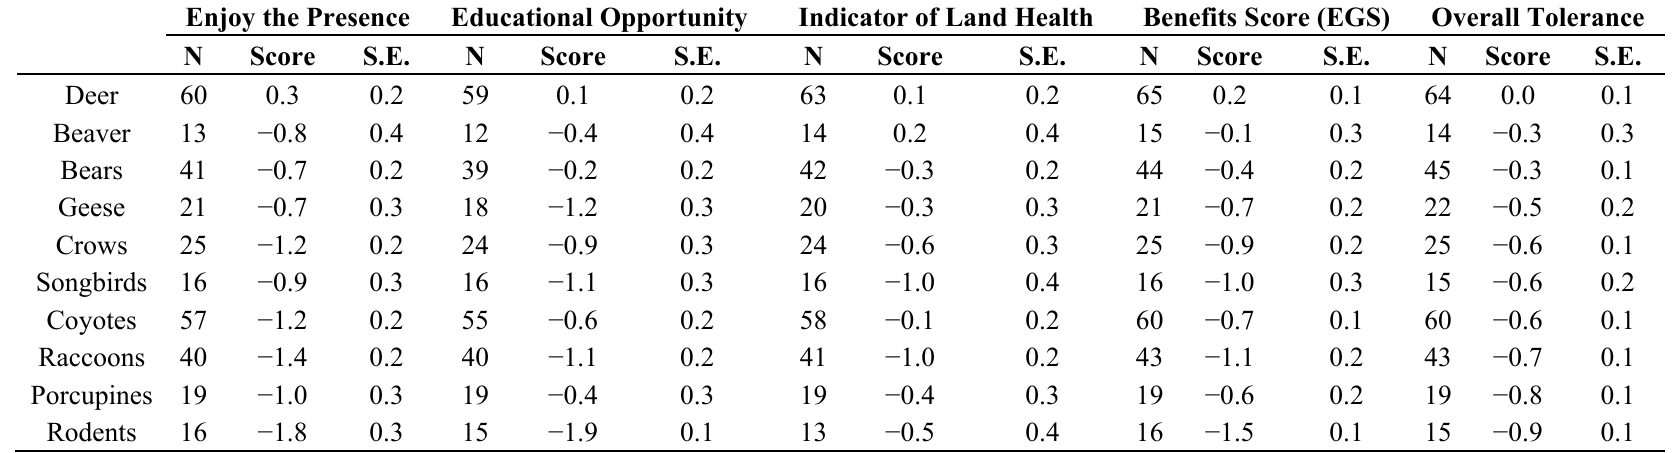
Table 4. Cultural benefits perceived by survey respondents about the most commonly nominated “nuisance” species, sorted by overall desirability. Potential scores range from − 2 to +2, with the exception of “overall tolerance” which has a range of − 1 to